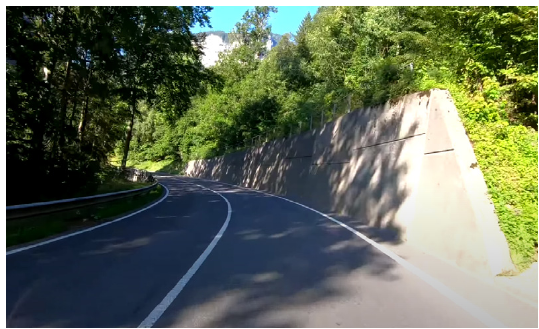
Figure 2. Shadows may cause fake lane edges.